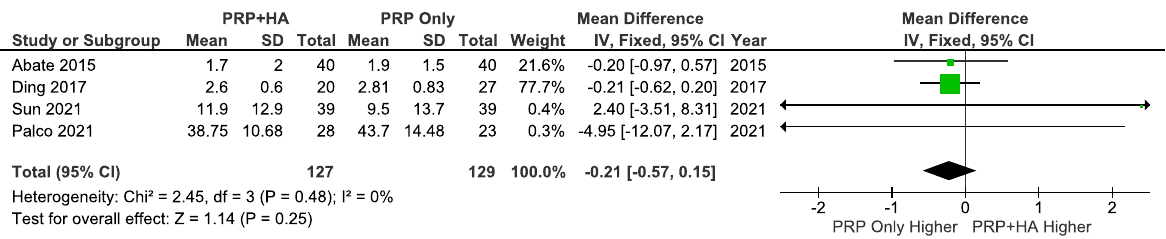
HA and PRP at 3 months after treatment +